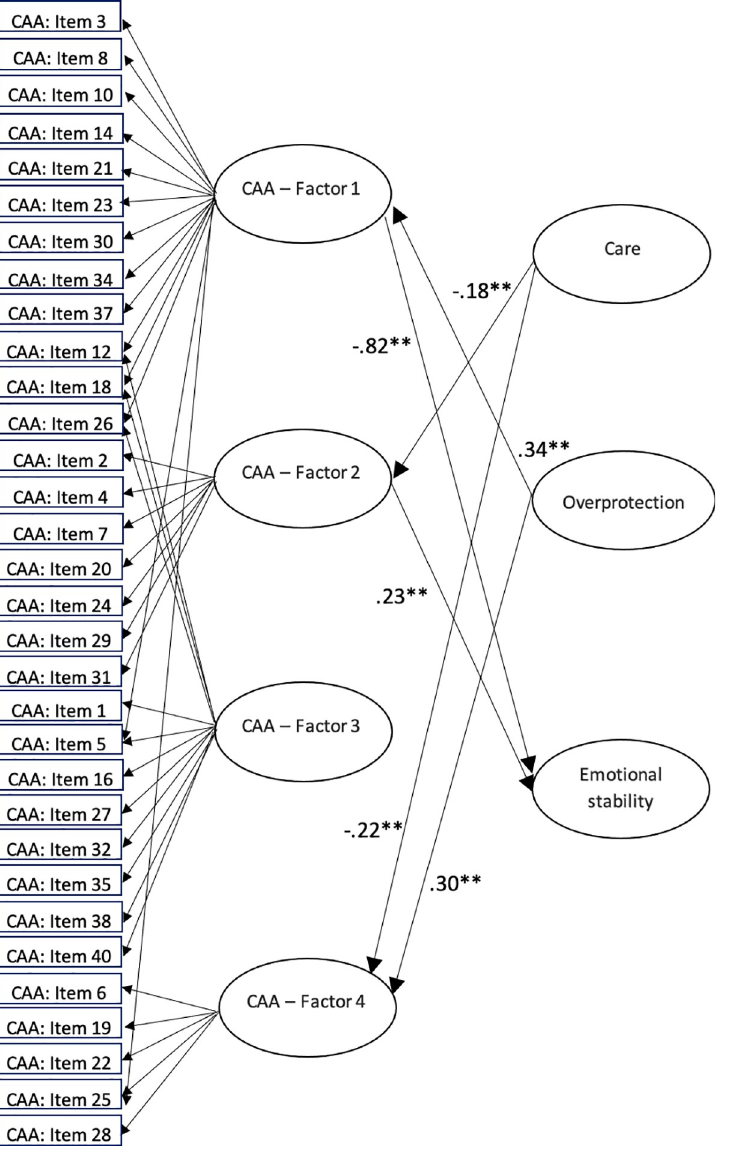
Fig 1. Structural equation model for the insecure attachment